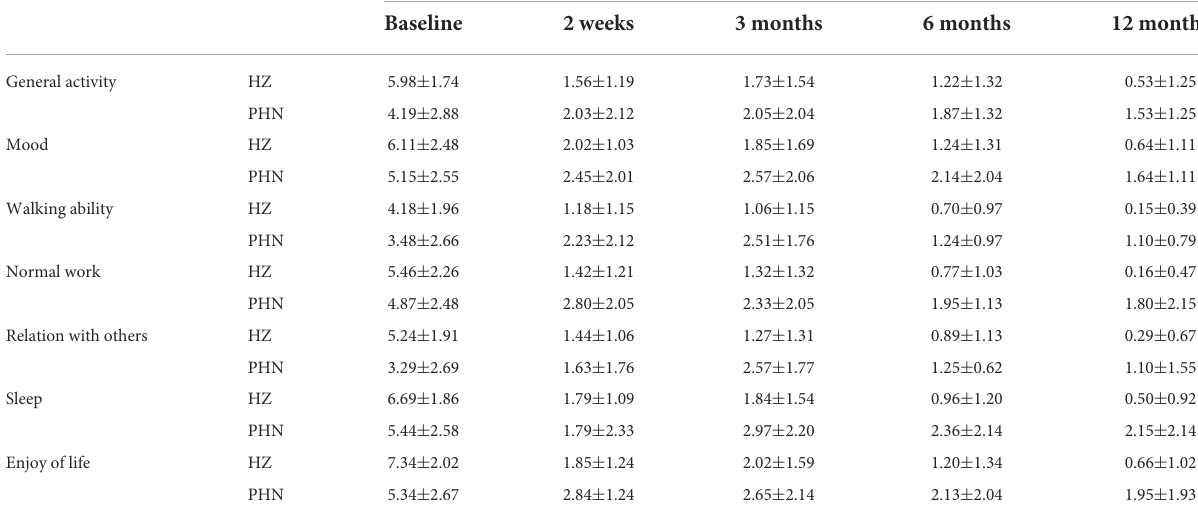
TABLE 4 Dimensions of BPI scores of patients with HZ and